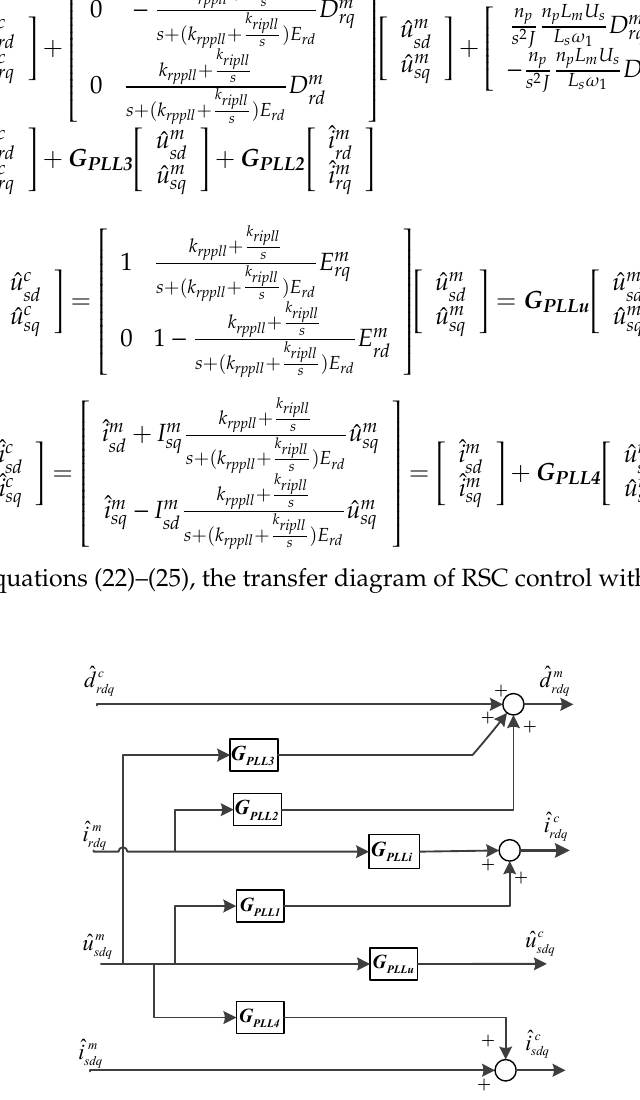
Figure 8. The small-signal transfer diagram of PLL in the RSC control. This PLL model links the variables from the circuit module to the control module.